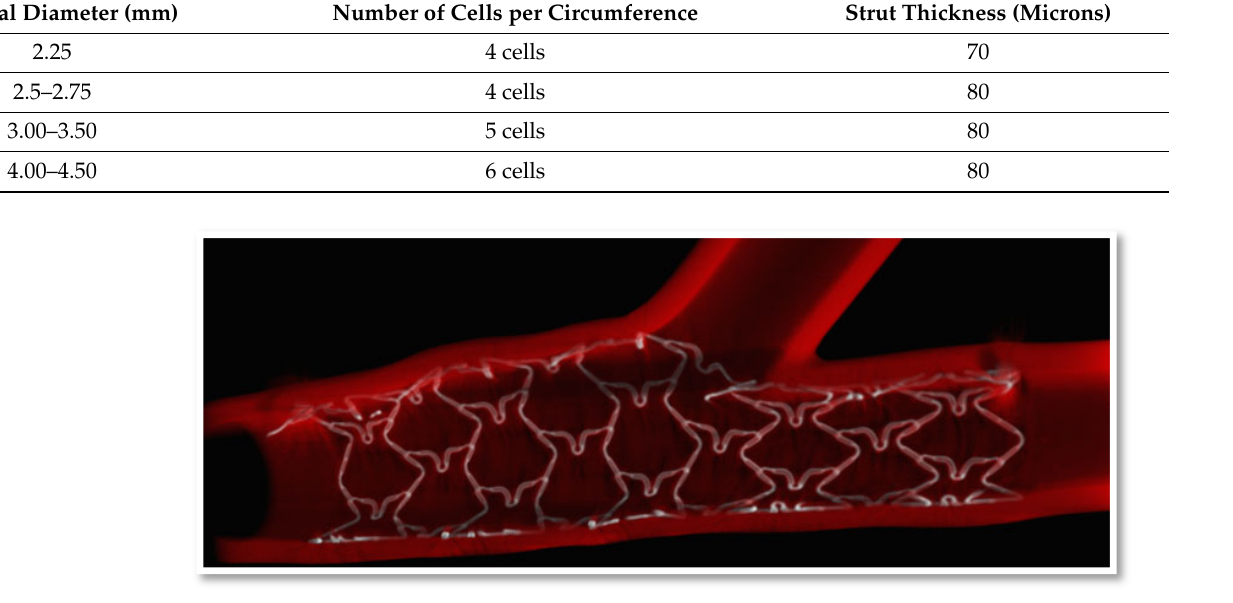
Figure 1. Optimal scaffolding of the Cre8 eluting stent in arterial bifurcation. With permission from